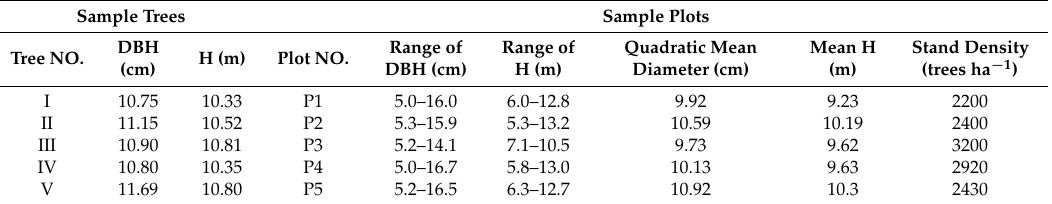
Table 1. Attributes of sample plots and corresponding sample trees for Larix olgensis Henry plantation. Sample Trees Sample Plots NO. Tree NO.